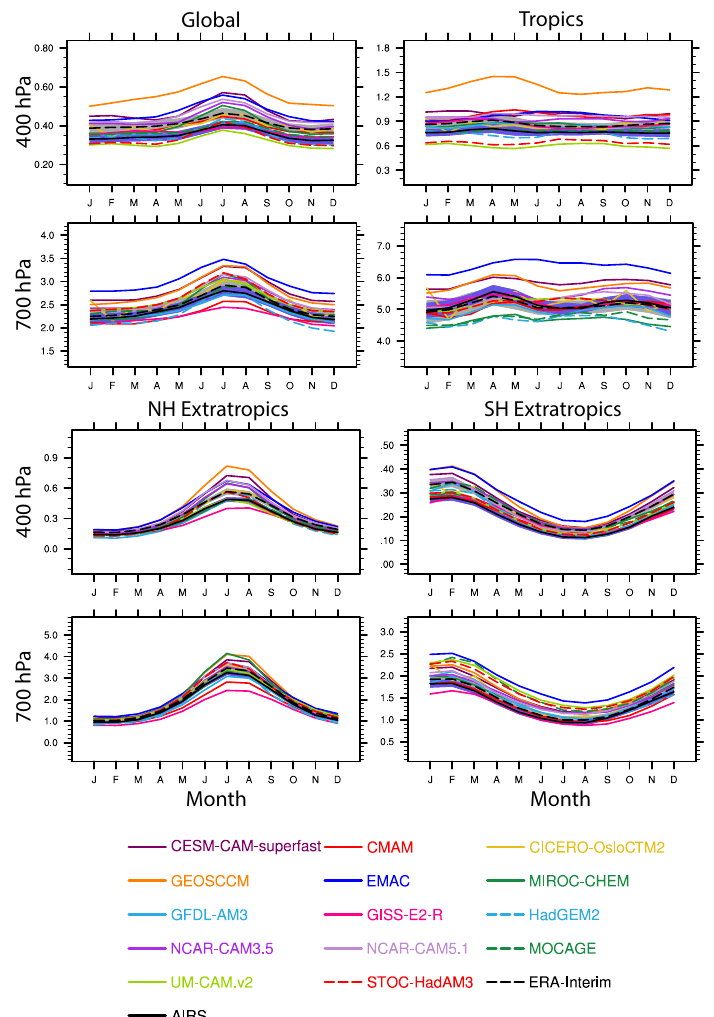
Fig. 7. Seasonal cycle of specific humidity (gkg − 1 ); reanalysis data are from the ERA-Interim and AIRS are satellite retrievals (see text for details).